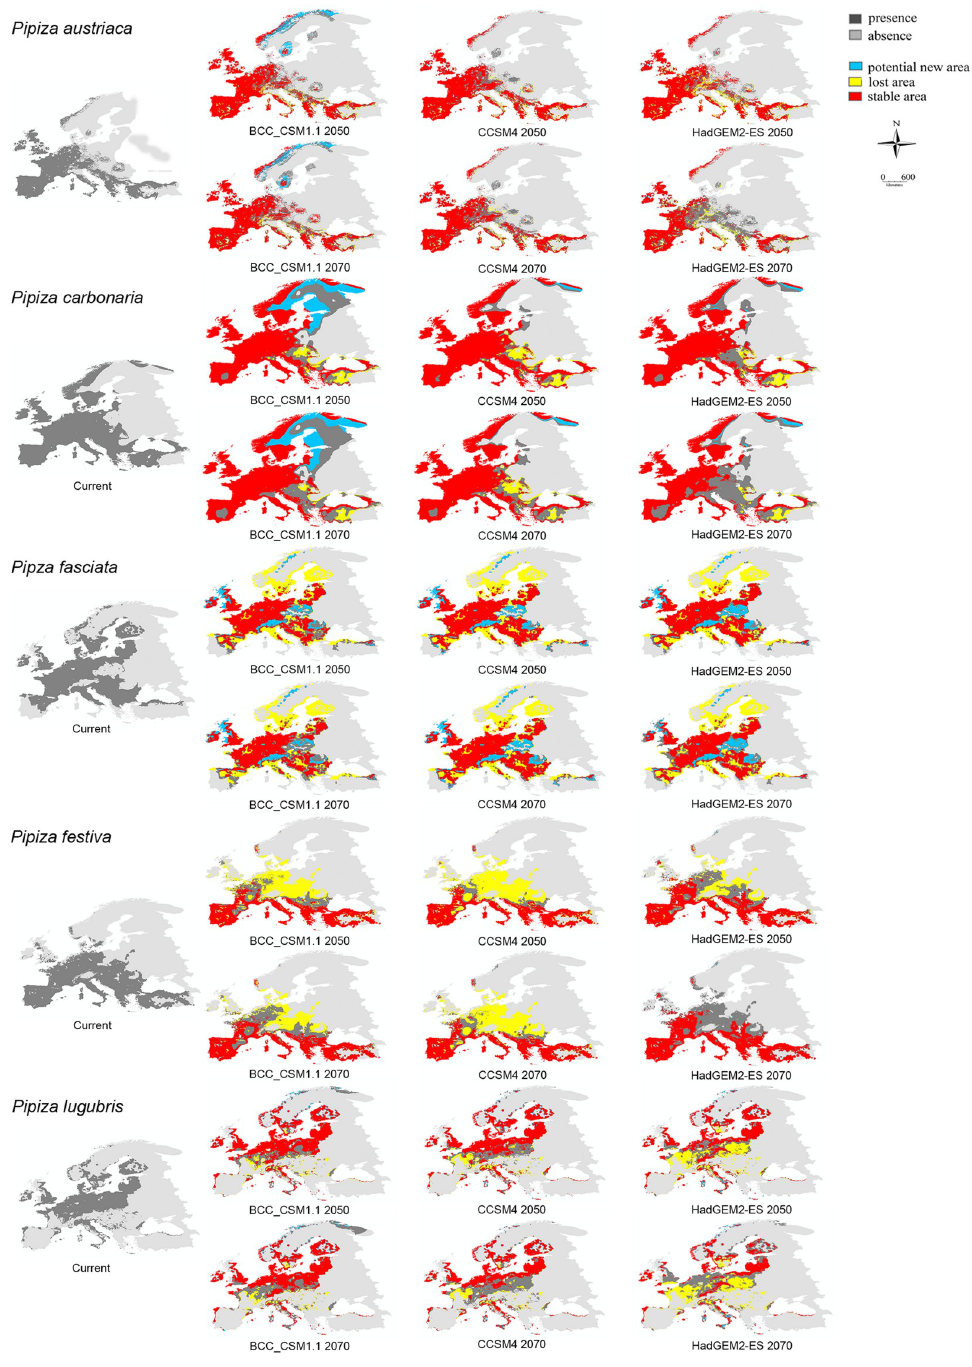
Fig 2. Modelled species distributions under current climate and future climatic models and all scenarios for: P . austriaca , P . carbonaria , P . fasciata , P . festiva , P . lugubris .